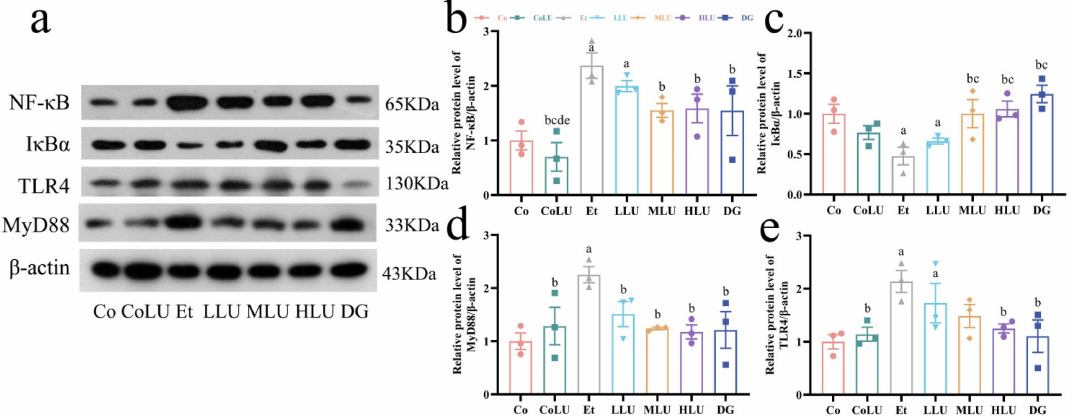
Figure 4. Effects of lutein on expression of proteins associated with inflammatory pathways. ( a ) The protein expression levels of NF- κ B ( b ), I κ B- α ( c ), MyD88 ( d ), and TLR4 ( e ) ( n = 3/group). The data were shown with mean ± SEM. Co: normal control group; CoLU: the medium-dose lutein control group; Et: ethanol model group; LLU: the low-dose lutein intervention group; MLU: the medium-dose lutein intervention group; HLU: the high-dose lutein intervention group; DG: positive control group. a p < 0.05 vs. Co group, b p < 0.05 vs. Et group, c p < 0.05 vs. LLU group, d p < 0.05 vs. MLU group, e p < 0.05 vs. HLU